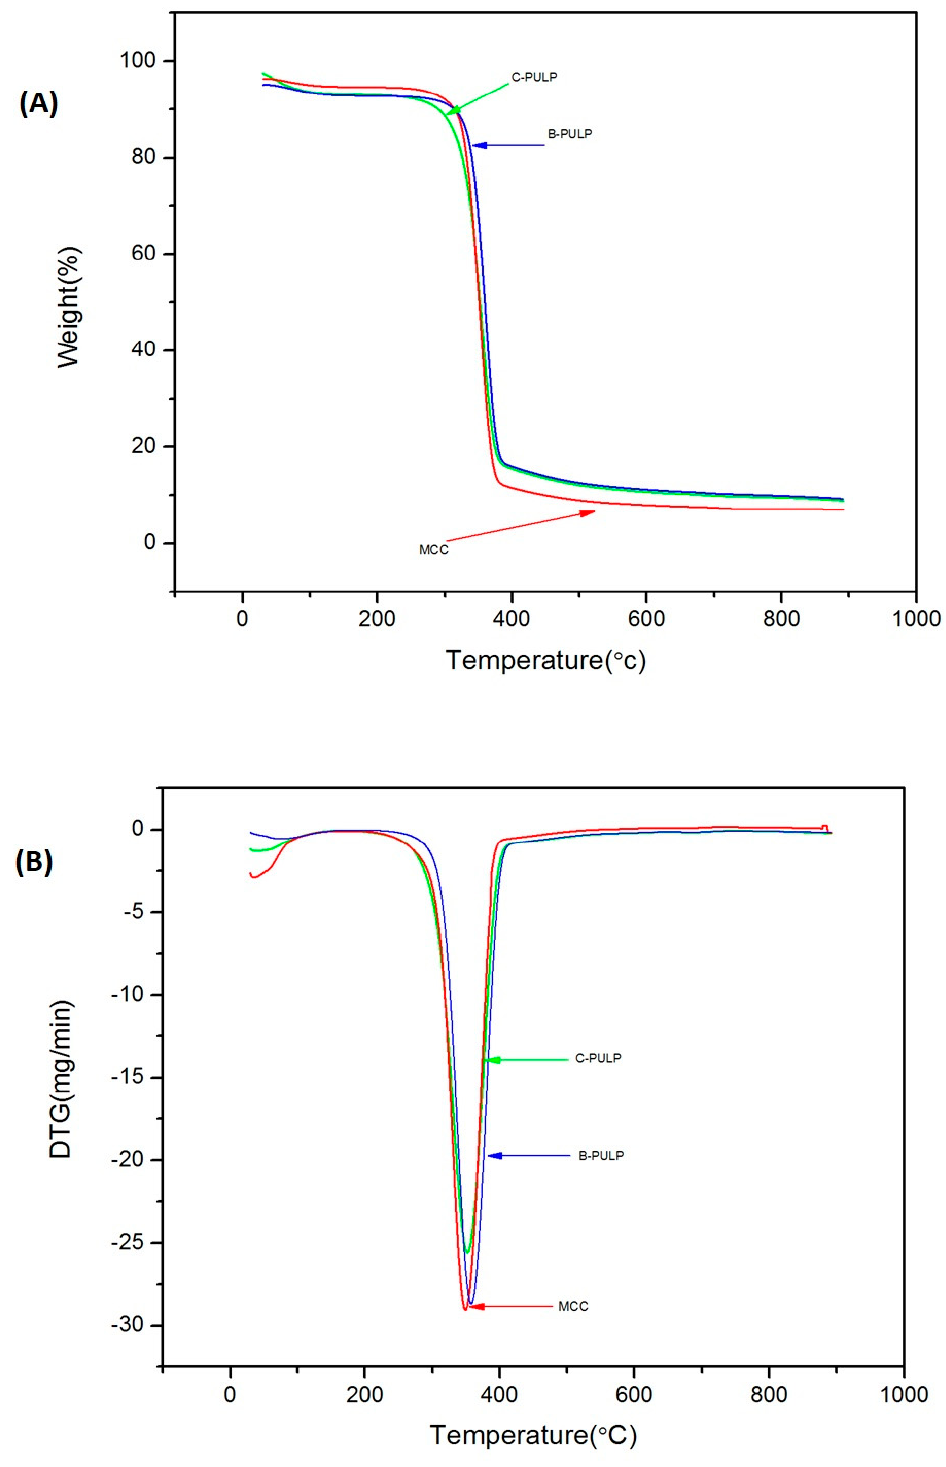
Figure 6. TGA curves of B-Pulp, C-Pulp and MCC samples ( A ) and DTG curves of B-Pulp, C-Pulp and MCC samples ( B ). Analysis of thermal properties was performed as given in the methods section.